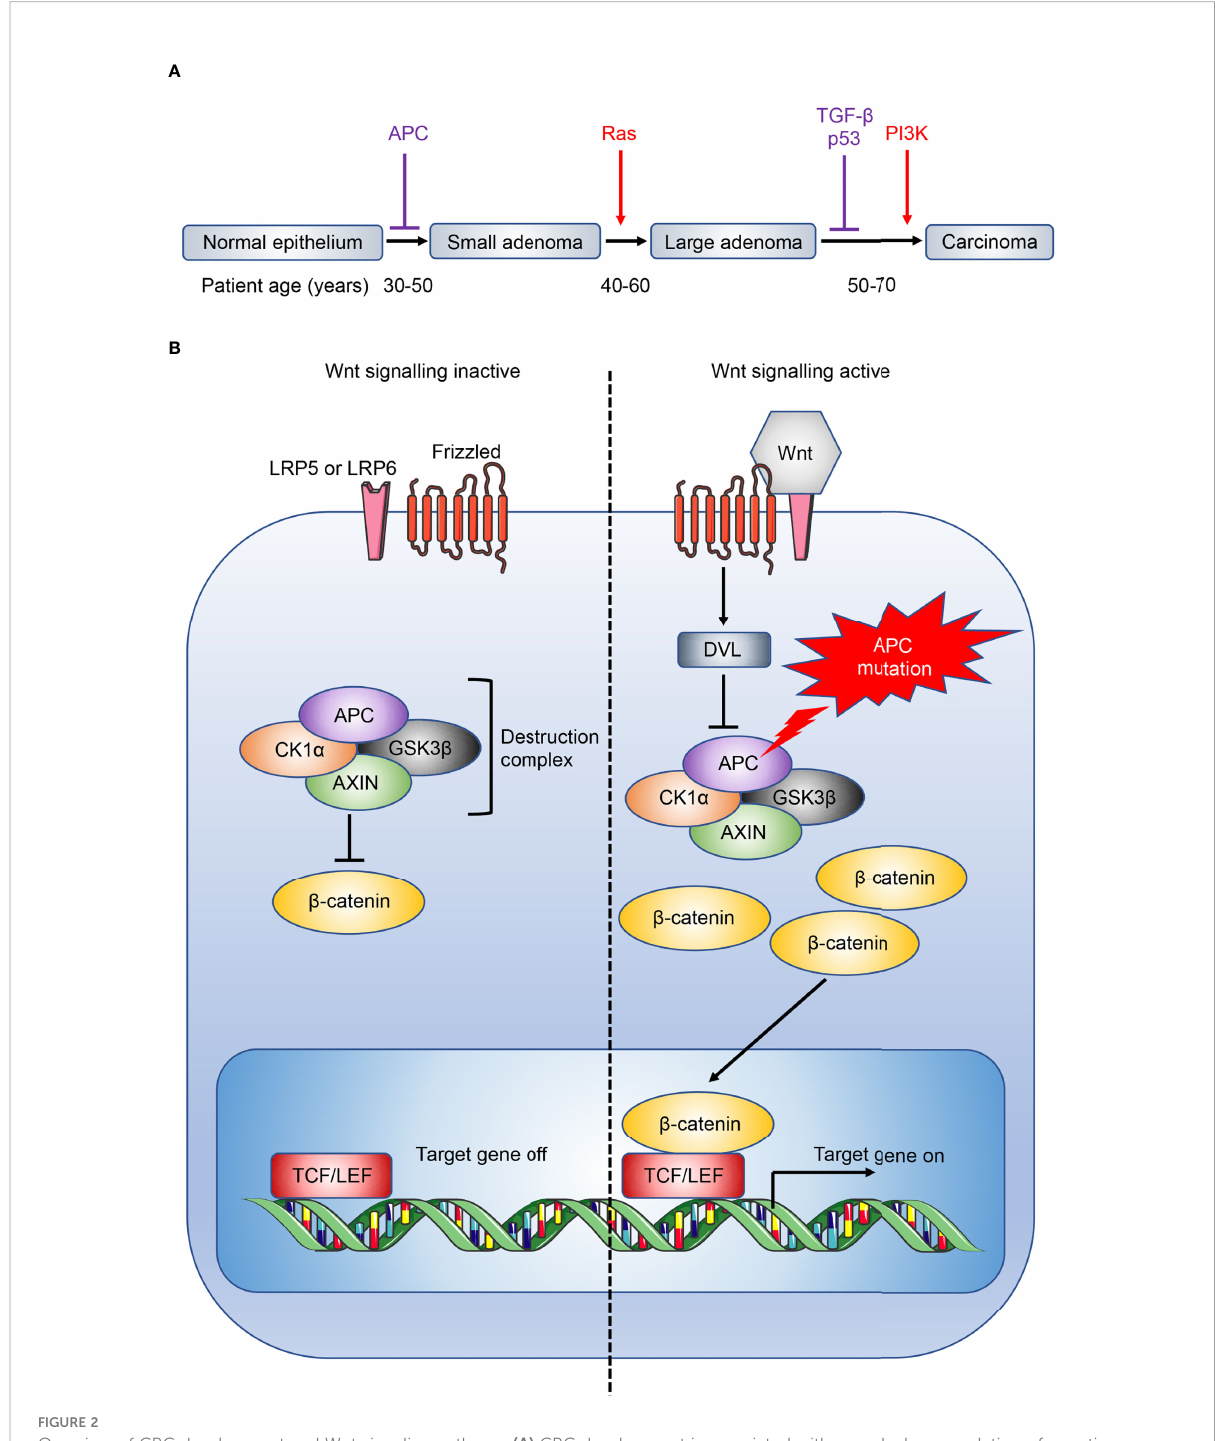
FIGURE 2 Overview of CRC development and Wnt signaling pathway. (A) CRC development is associated with a gradual accumulation of genetic alterations involving the loss of tumour suppressors (purple) or gain of oncogenic function (red). Loss of the tumour suppressor adenomatous polyposis coli (APC) facilitates the initial transition from normal epithelium to adenomas. Patient age when the driver genes are commonly mutated are also shown (66). Ras, rat sarcoma virus; TGF- b , transforming growth factor- b ; p53, tumour protein p53; PI3K, phosphatidylinositol 3-kinase. (B) The destruction complex, consisting of APC, AXIN, casein kinase 1 a (CK1 a ) and glycogen synthase kinase 3 b (GSK3 b ), induces the continuous degradation of b -catenin in the absence of Wnt signaling. The destruction complex is disassembled when Wnt ligand binds to its receptor frizzled and coreceptor lipoprotein receptor-related protein 5 or 6 (LRP5 or LRP6 respectively), or when APC is mutated, leading to the accumulation and nuclear translocation of b -catenin, and downstream Wnt signaling (67). DVL, dishevelled; TCF/LEF, T cell factor/lymphoid enhancer